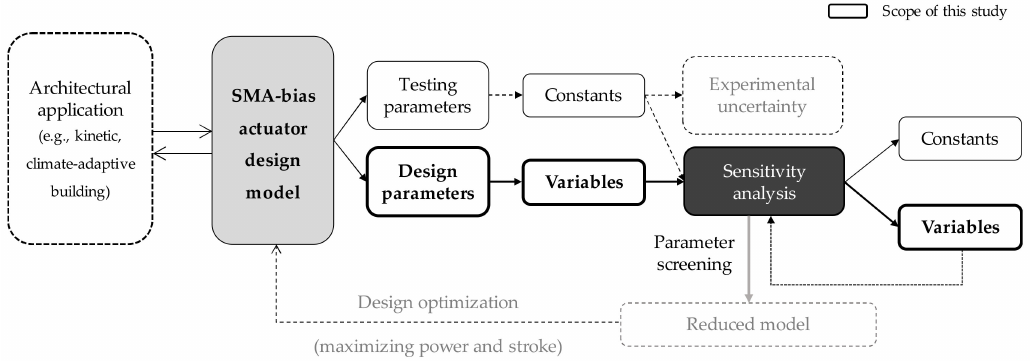
Figure 2. Scheme of the study scope and